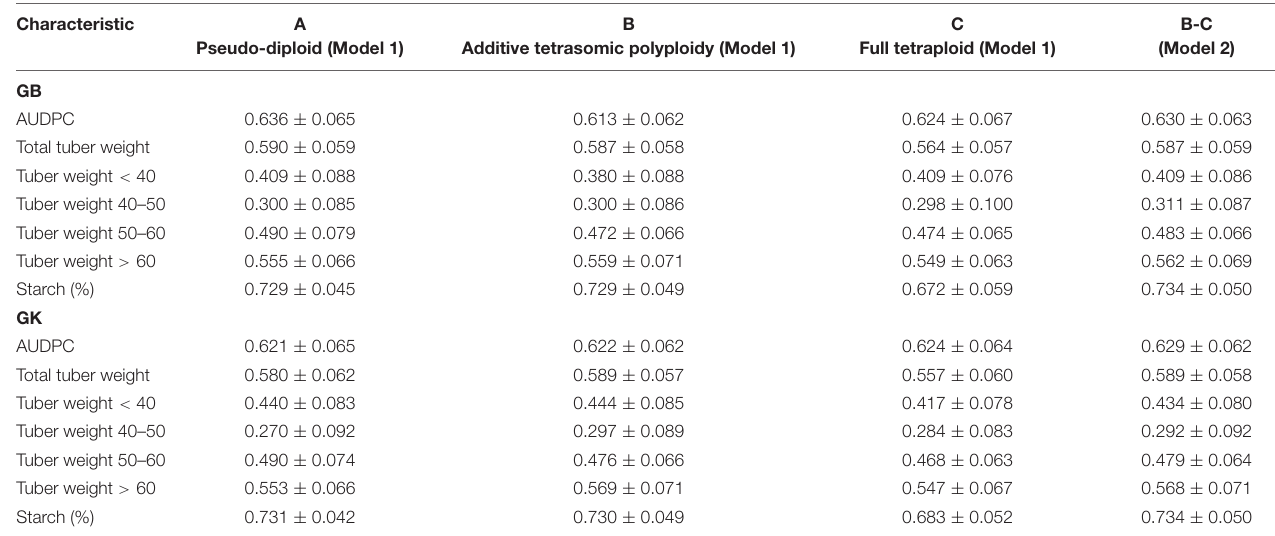
TABLE 3 | Single-environment genomic best linear unbiased predictor (GBLUP) (GB) and Gaussian kernel (GK) prediction accuracy ( ± standard deviation) for potato tuber characteristics and host plant resistance to late blight (measured by area under disease progress curve or AUDPC) considering pseudo-diploid (A) (model 1), additive tetrasomic polyploid (B) (model 1), and full tetraploid (C) (model 1) and B-C (model 2) with 30 random partitions (70% training and 30% testing) in Mosslund a 2020 ( N =